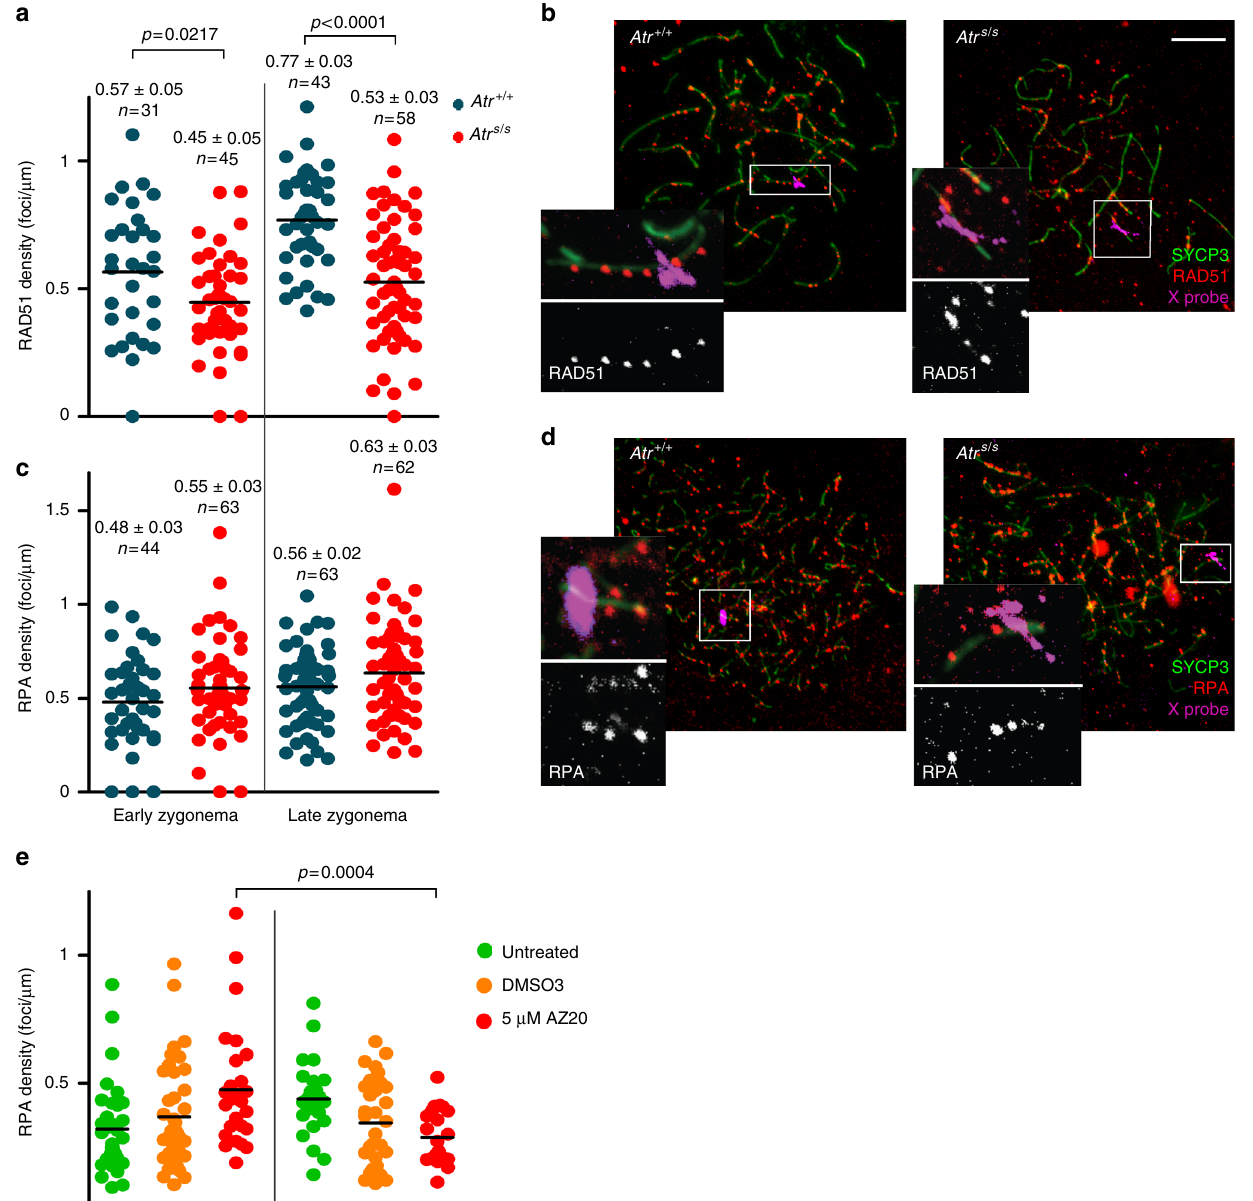
Fig. 6 ATR function is needed for normal levels of recombination markers on unsynapsed axes. a RAD51 focus density along the entire measurable X- chromosome axis. Horizontal black lines denote the means. P values are from t tests. b Representative images of late zygotene spermatocytes. Images show overlays of immuno fl uorescence against SYCP3 and RAD51 with fl uorescence in situ hybridization (FISH) for the X-PAR boundary. Scale bar = 10 μ m. Inset images show RAD51 foci on the measurable X-chromosome axis. c RPA focus density on the measurable X chromosome. d Images of early zygotene spermatocytes showing immuno fl uorescence against SYCP3 and RPA, overlaid with FISH for X-PAR boundary. Inset images show RPA foci on the measurable X-chromosome axis. e RPA focus numbers present on unsynapsed axes at D14 from spermatocytes cultured in The membrane was probed with ATR antibody (Abcam, 1:15000 dilution) and rounds of immunoprecipitation with an anti-SPO11 monoclonal antibody (Spo11- tubulin antibody (Abcam, 1:5000 dilution). 180) on Protein A-agarose beads (Sigma). SPO11-oligonucleotide complexes were labeled with [ α - 32 P] dCTP using terminal deoxynucleotidyl transferase (Fisher), released by boiling in Laemmli buffer and fractionated by SDS-PAGE. The elec- In vivo drug administration . AZ20 (Selleckchem) compound dissolved in 10% trophoresed products were transferred onto polyvinylidene fl uoride (PVDF) DMSO/40% propylene glycol/50% water was administered orally to adult wild-type membrane. Radiolabeled species were detected using Fuji phosphor screens and males at a single daily dose of 50 mg/kg for 3 or 7 consecutive days or to Spo11 – / – quanti fi ed with ImageGauge software. The membrane was probed with the SPO11 males for 7 days. Control animals were administrated with the same volume of antibody at 1:2000 dilution. vehicle solution. Allocation of treated and control animals to each group was For western blot analysis, wild type and Seckel mouse testis protein extracts performed randomly. Animals were killed 24 h after the treatment ended. were obtained by mincing the tissues in RIPA buffer and boiling them for 10 min. After centrifugation, supernatants were run in a 4 – 20% gradient SDS-PAGE. Transfer to a nitrocellulose membrane was performed using a Trans-Blot Turbo Neonatal testis organ culture . Five dpp mouse testes were cultured as previously System (Bio Rad). described 61 . Brie fl y, 1.5% agarose gel cubes were placed in a six-well plate and